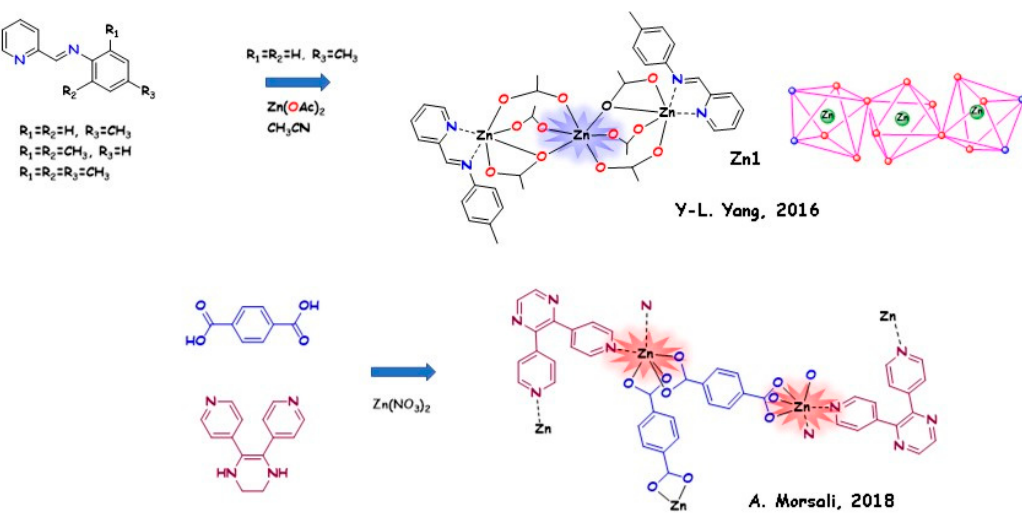
Figure 2. MOFs acting as highly fluorescent Zn AIEgens.